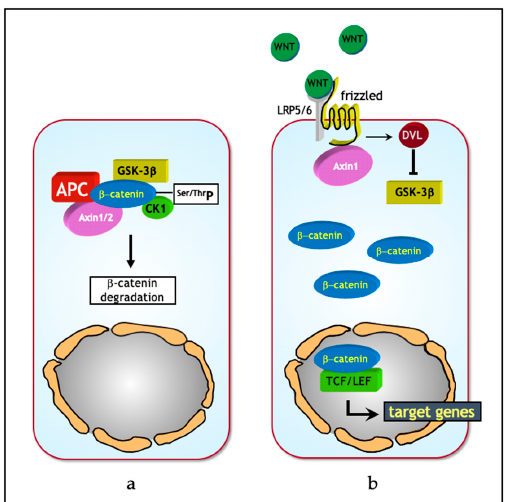
Figure 1. The Wnt / β -catenin signal transduction pathway in homeostasis. ( a ) In the absence of Wnt ligands, intracellular β -catenin levels are controlled by a destruction complex encompassing protein phosphatase 2A (PP2a), glycogen synthase kinase 3 (GSK3 β ) and casein kinase 1 α (CK1 α ), adenomatous polyposis coli (APC), and AXIN1 / 2. This complex binds and phosphorylates β -catenin at serine and threonine residues, thereby targeting it for ubiquitination and proteolytic degradation by the proteasome. ( b ) In presence of Wnt, co-activation of the Frizzled and low-density lipoprotein receptor-related protein 5 / 6 (LRP5 / 6) (low-density lipoprotein receptor-related proteins) receptors prevents the formation of the destruction complex leading to the stabilization and consequent translocation of β -catenin from the cytoplasm to the nucleus. Here, β -catenin interacts with members of the T-cell specific transcription factor / lymphoid enhancer binding factor (TCF / LEF) family of transcription factors and modulates the expression of a broad spectrum of Wnt downstream target genes. DVL – disheveled. Adapted from